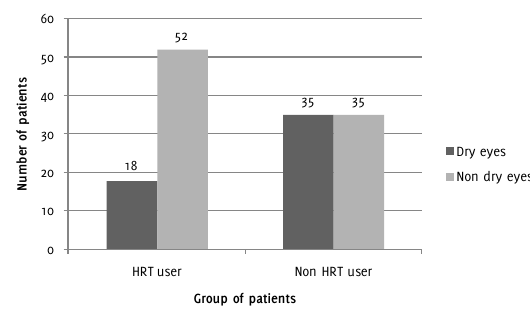
Figure 1. Comparison of the occurrence of dry eyes between HRT users and non HRT users. There was significant difference between these two groups. HRT users showed significant reduction in the number of patients with dry eyes. (p=0.003)